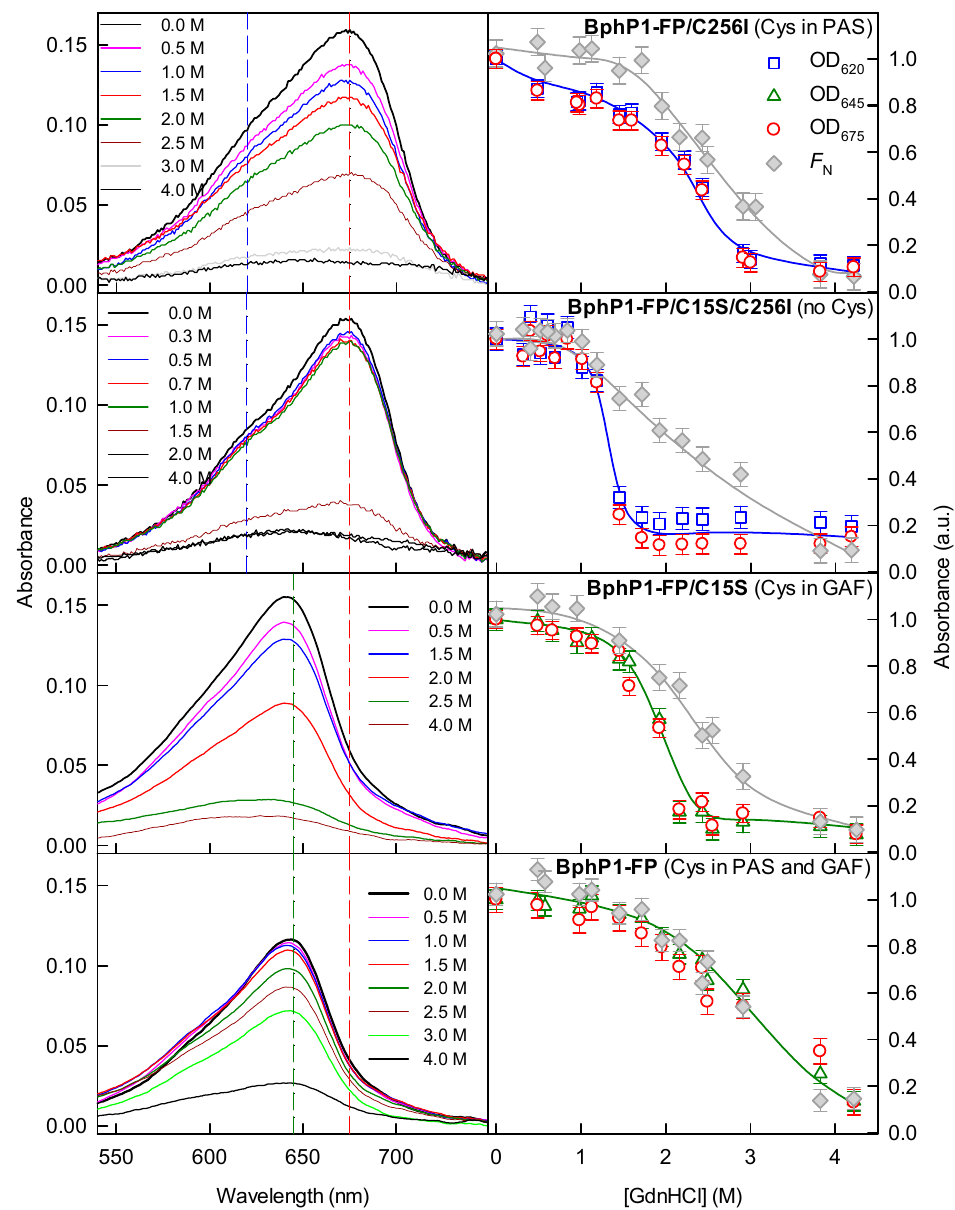
Figure 4. GdnHCl-induced changes in absorption of BphPl-FP variants. Absorption spectra are shown in the left panels. The numbers on the curves indicate the final denaturant concentrations in the protein samples. In the right panels the dependences of optical density at selected wavelengths (620 and 675 nm (blue and red vertical dashed lines in the left panels), or at 645 and 675 nm (green and red vertical dashed lines in the left panels)) on the GdnHCl concentration are presented. The data were normalized to BphPl-FP absorption at the respective wavelength in buffered solution. Stability of the protein structure against GdnHCl-induced unfolding is shown as the dependences of the part of native molecules F N on the GdnHCl concentration (gray symbols). F N was calculated from ellipticity at 222 nm. The selection of the wavelengths in these experiments was based on the observation that Cys256-BV adduct has the blue-shifted absorption with respect to Cys15-BV adduct and non-covalently bound BV. Thus, in the case of NIR FP proteins with Cys256 in GAF domains only we used wavelengths corresponding to the absorption maxima of Cys256-BV and non-covalently bound BV, 645 and 675 nm for BphP1-FP variants. In the NIR FPs proteins with Cys15 in PAS domains only, covalently and non-covalently bound chromophores are spectrally indistinguishable. In this case additionally to the maximum of Cys15-BV absorption (675 nm), the wavelength at blue-edge of protein absorption spectra (i.e., 620 nm) was selected as control.